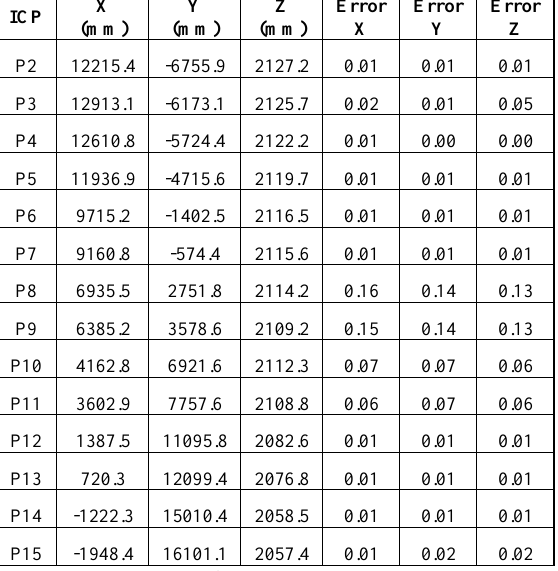
Table 6. Results of SF6 GIL coordinates in session 2